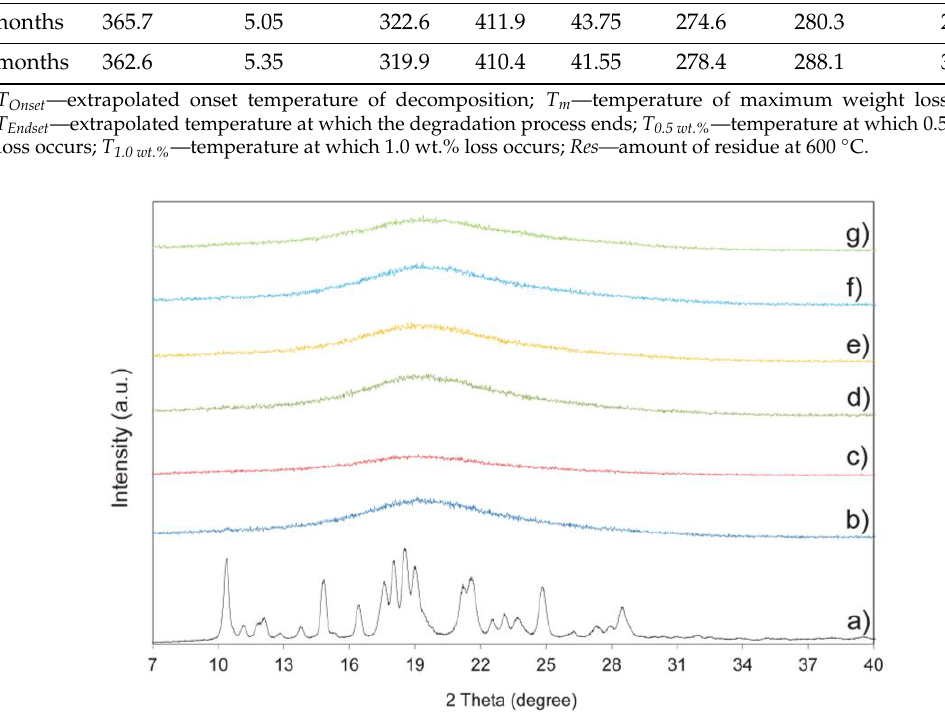
Figure 6. X-ray powder diffractometry (XRPD) pattern of crystalline imatinib mesylate (IM) ( a ) and amorphous IM stored at 25 °C under controlled relative humidity at different ageing times: ( b ) day